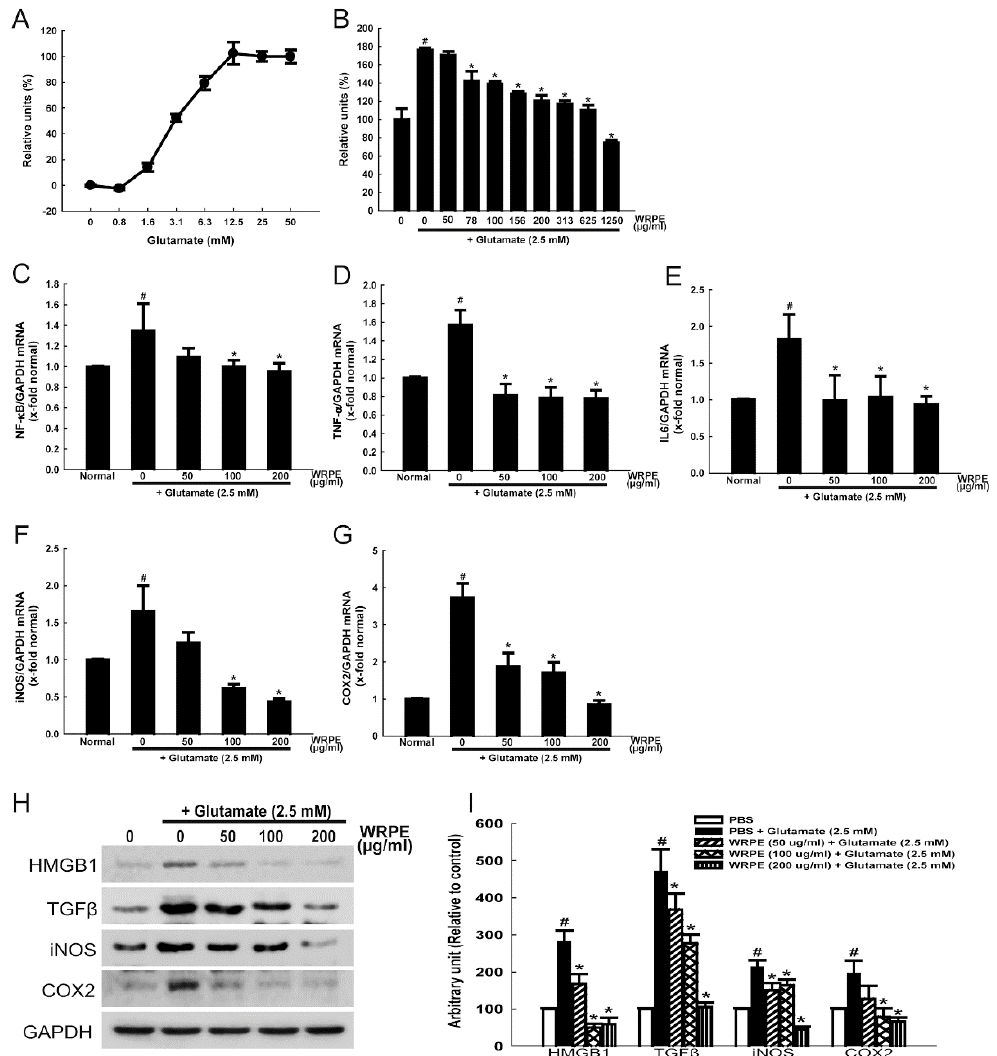
Figure 3. Neuroprotective activity of white rose petal extract (WRPE) against glutamate cytotoxicity in human neural stem cells (NSC). ( A ) Cytotoxicity of glutamate in LDH assay. ( B ) Protective effect of WRPE on glutamate-induced cytotoxicity in LDH assay. ( C – G ) Real-time PCR analysis of mRNA of NF- κ B ( C ), TNF- α ( D ), IL-6 ( E ), iNOS ( F ), and COX2 ( G ) normalized to GAPDH. ( H , I ) Western blot analysis of proteins of HMGB1, TGF- β , iNOS, and COX2, showing representative bands ( H ) and band densities normalized to GAPDH ( I ). n = 5 per treatment group. # Significantly different from normal control ( p < 0.05). * Significantly different from vehicle control ( p < 0.05).